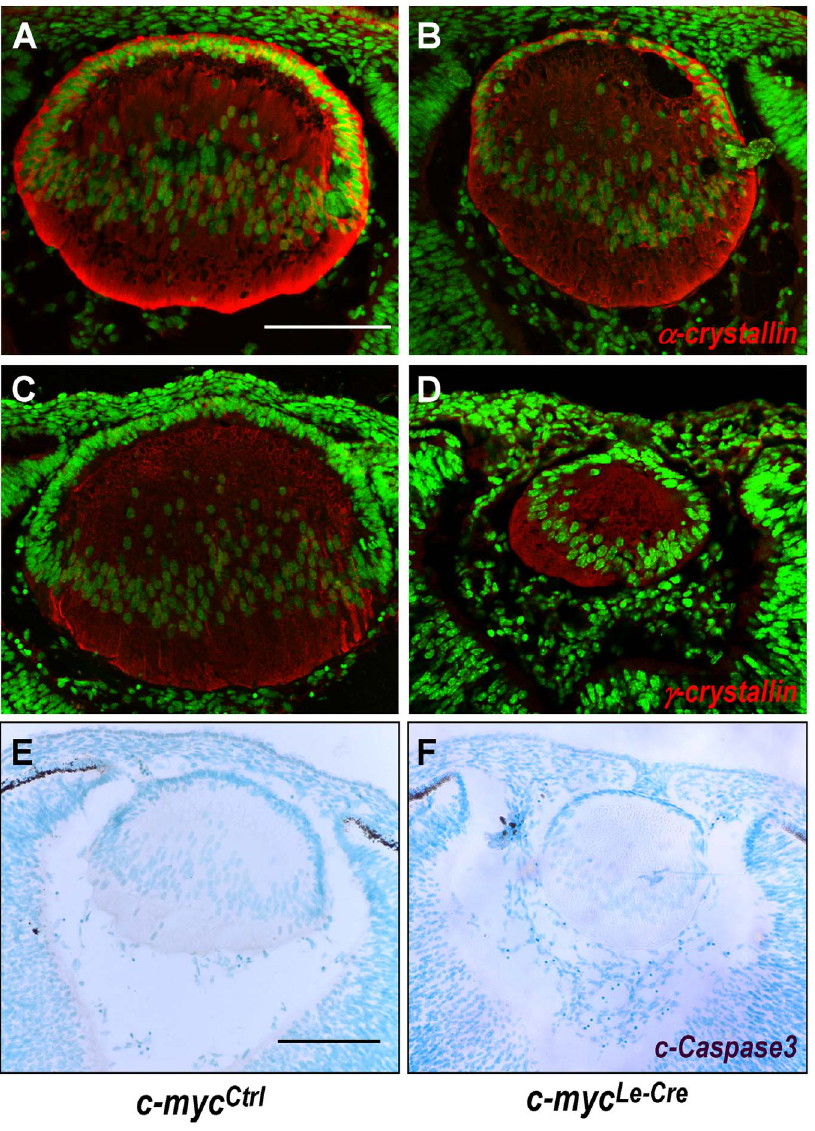
Figure 4. Inactivation of c-myc does not affect cell survival or the expression of crystallins. Representative confocal pictures of the immunofluorescence for a ´ - crystallin ( A–B ) or a ˜ -crystallin ( C–D ) performed in control ( c-myc Ctrl ) and c-myc-deficient ( c-myc Le-Cre ) lens sections at E13.5. Sytox nuclear counterstaining is shown in green. Immunostaining patterns are indistinguishable between c-myc–deficient and control lens. ( E– F ) Representative pictures of cleaved caspase-3 staining of control ( E ) and c-myc–deficient (F) lens at E13.5. c-myc loss did not lead to misregulation of apoptosis during embryonic lens development. Scale bar: 100 m m.